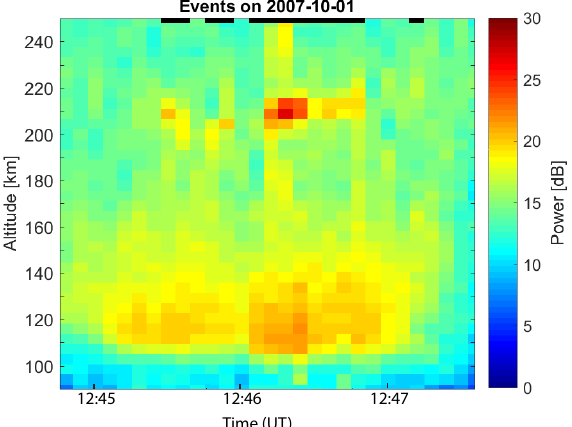
Figure 1. Received backscattered power as a function of time and altitude on 1 October 2007. In addition to the E region ioniza- tion, strong backscatter enhancements are found in a thin layer at ∼ 210km altitude. The data dumps with detected anomalous echoes are marked with black bars at the top of the